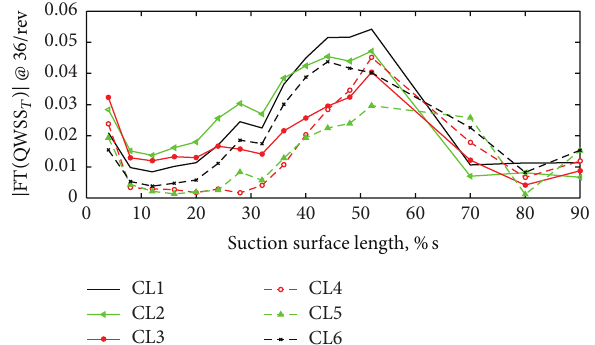
Figure 9: Magnitude of FT at Rotor 1 blade passing frequency for six clocking